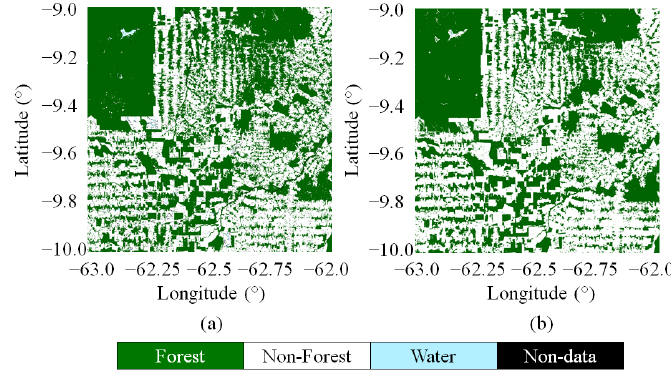
Figure 11. Validation maps obtained for geocell S10W063 over the state of Rondônia, Brazil: ( a ) Sentinel-2 and ( b ) TanDEM-X FNF maps from